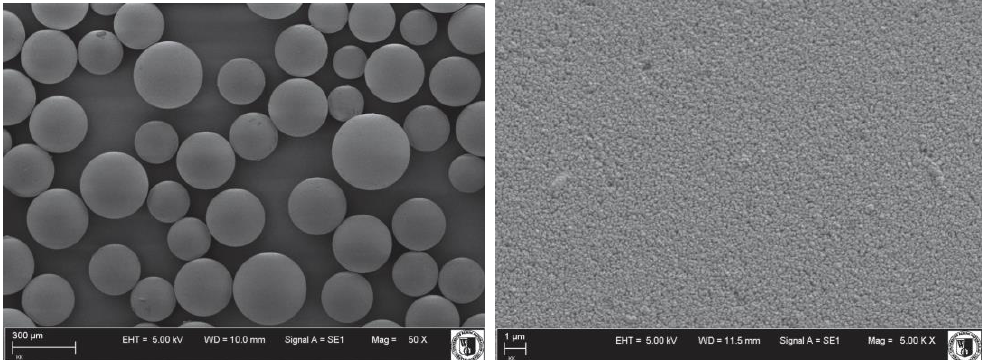
Figure 2. Scanning electron microscope (SEM) images of modified poly(divinylbenzene) beads. The carboxylic group content in the structure of the proposed adsorbent results from the effectiveness of modifying free vinyl groups of poly(divinylbenzene). Whereas the number of vinyl groups that can be modified depends on the polymerization